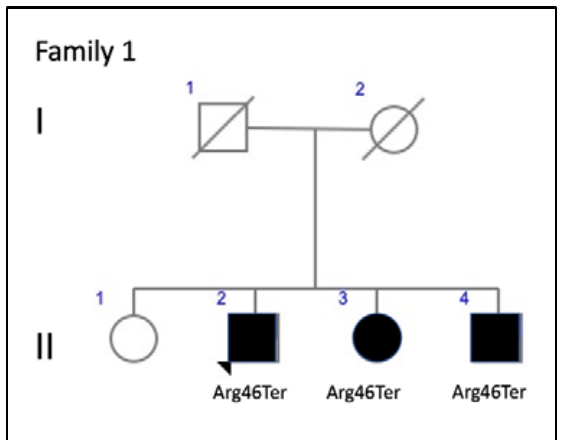
Figure 2. Family 1 pedigree. Figure 2. Family 1